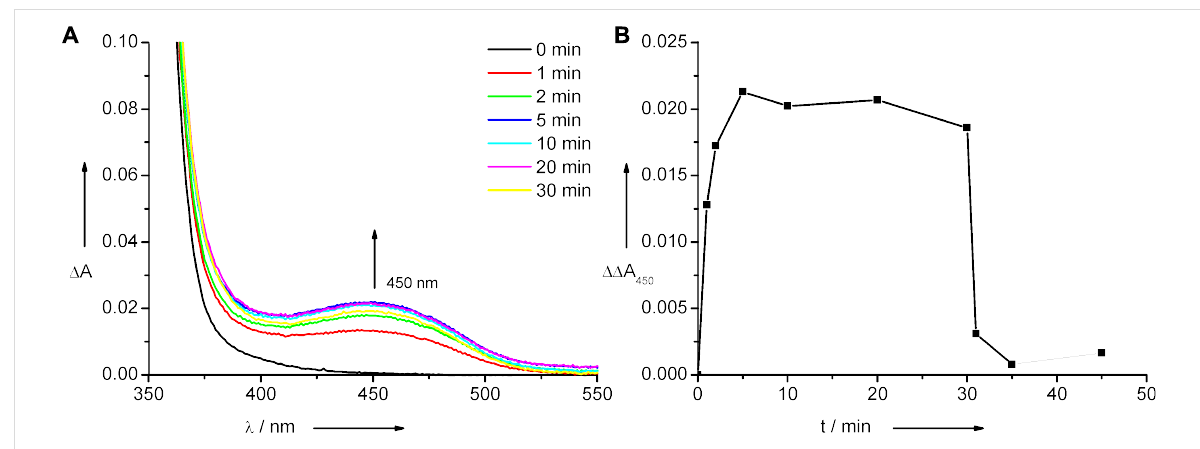
Figure 2: Irradiation of ds DNA2 at 310 nm ( A , left) and plot of kinetic trace of absorption changes at 450 nm of ds DNA2 irradiated at 310 nm until 30 min, then 450 nm ( B ,